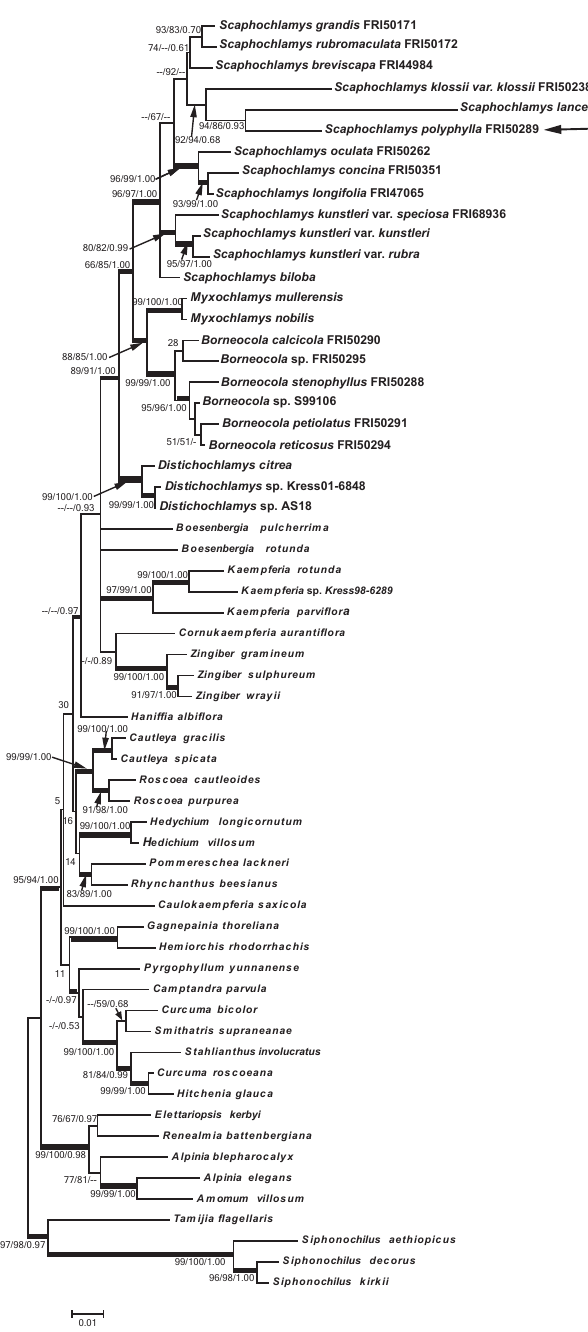
Figure 3. Molecular phylogenetic analysis of the ITS+matK sequence data by the Maximum Likelihood method. Numbers above branches indicate bootstrap values of ML and MP and posterior probability of Bayesian